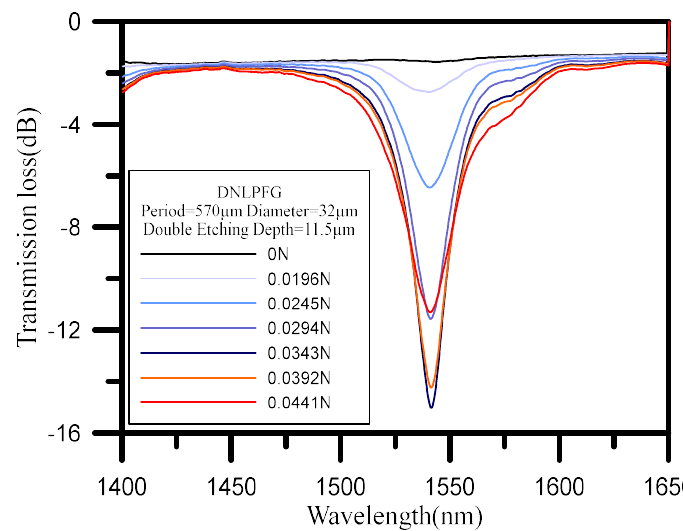
Figure 5 . The transmission spectra of DNLPFG sensor under tensile loading .